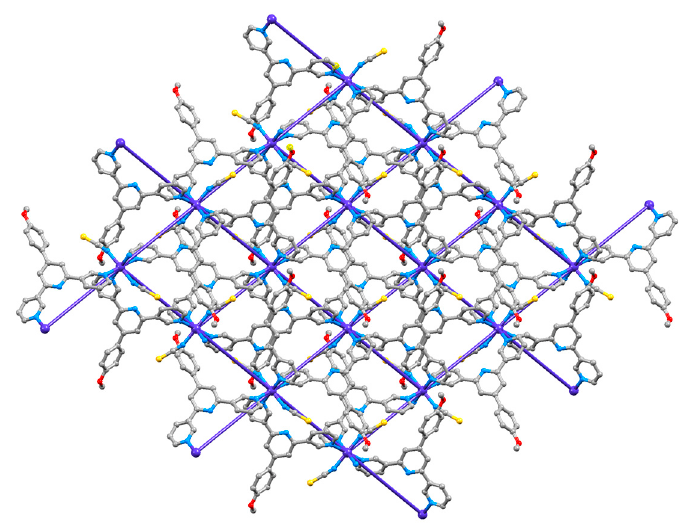
Figure 9. Part of one 2D network of [Co( 2 ) 2 (NCS) 2 (MeOH) 2 ] n showing the 4-connecting Co nodes in the (4,4) net. the (4,4) net.